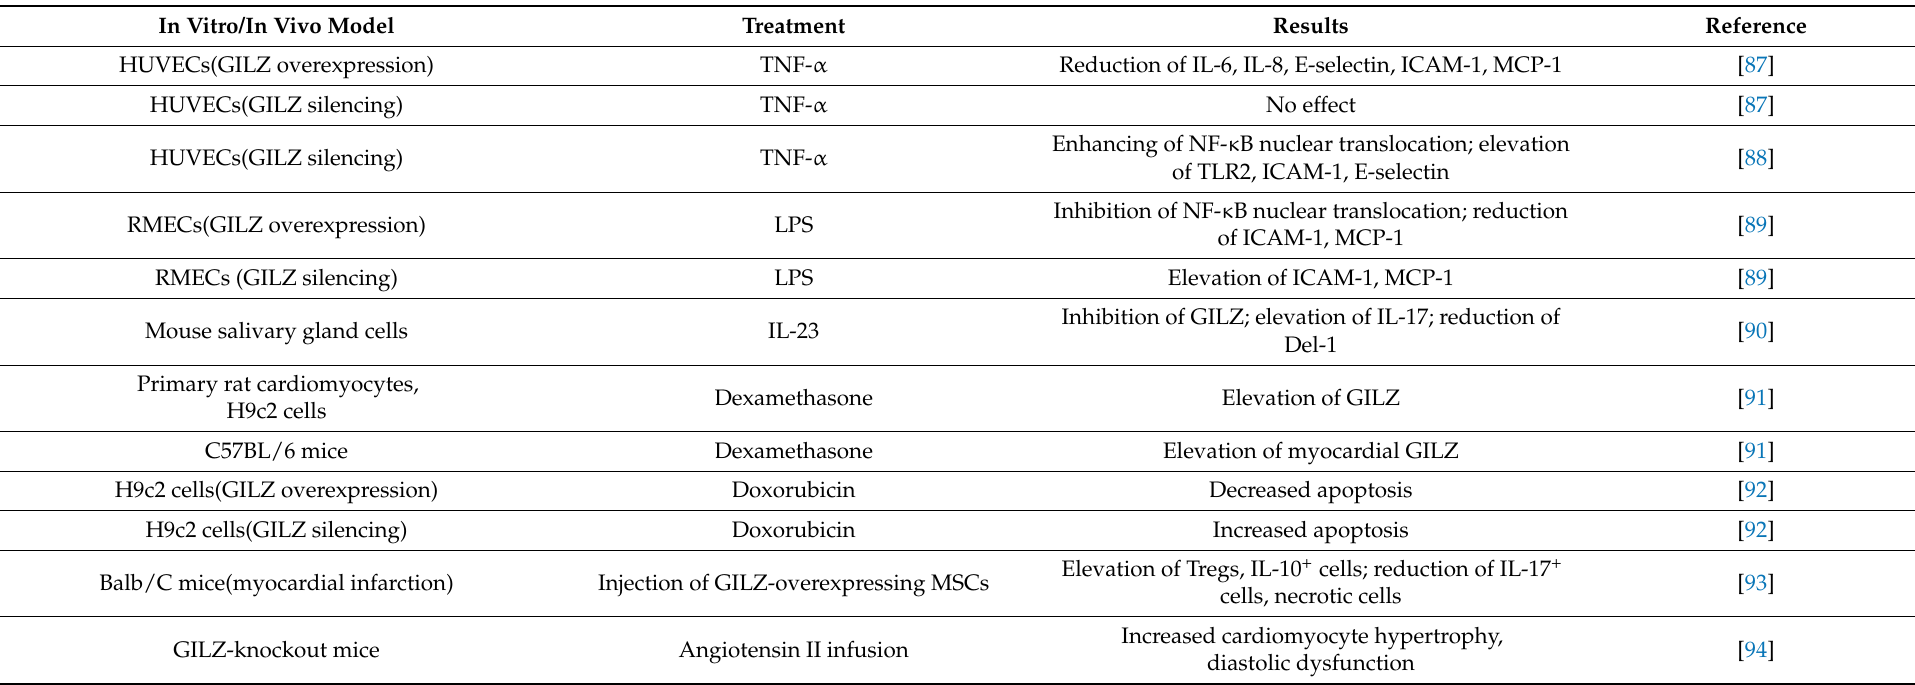
Table 1. Developmental endothelial locus 1; GILZ, glucocorticoid-induced leucine zipper; HUVECS, human umbilical vein endothelial cells; ICAM-1, intercellular adhesion molecule 1; IL-, interleukin-; LPS, lipopolysaccharide; MCP-1, chemokine monocyte chemoattractant protein-1; NF- κ B, nuclear factor- κ B; RMECs, retinal microvascular endothelial cells; TLR2, Toll-like receptor 2; TNF- α , tumor necrosis factor α ; Tregs, regulatory T